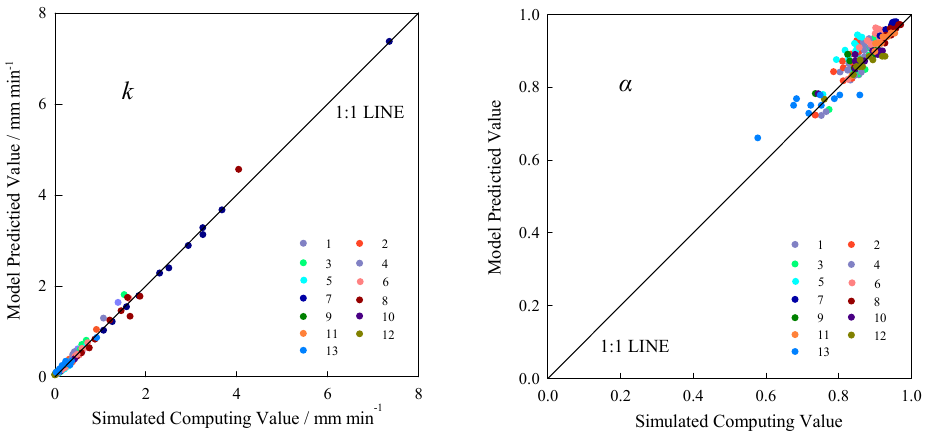
Figure 10. Comparison of simulated and estimated k and α . Nos. 1–13 indicate 13 types of tested soil form experiments performed using RETC software: 1 = silt loam (1.30 g·cm − 3 ); 2 = silt loam (1.30 g·cm − 3 ); 3 = sandy loam (1.35 g·cm − 3 ); 4 = sandy loam (1.45 g·cm − 3 ); 5 = loam; 6 = sand; 7 = sandy loam; 8 = loamy sand; 9 = silt; 10 = silt loam; 11 = sandy clay loam; 12 = clay loam; and 13 = silt clay loam.